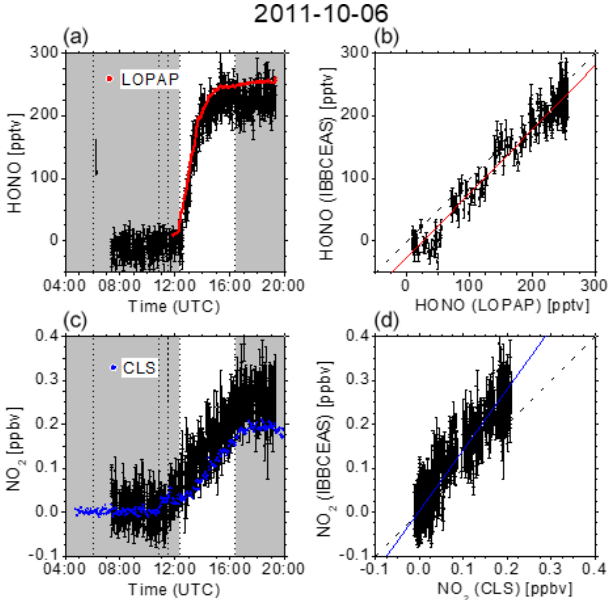
Figure 3. (a, c) Time-dependent HONO and NO 2 mixing ra- tios measured at SAPHIR on 5 October 2011. Dashed vertical lines indicate changes in the chamber conditions according to the experimental protocol: overnight flushing stopped (05:55UTC), 250pptv NO 2 (06:30 and 06:50UTC), 500pptv NO 2 (07:10 and 07:30UTC), 1ppbv NO 2 (07:50 and 08:10UTC), humidification started (08:41UTC), humidification stopped (09:25UTC), roof opened (09:27UTC), roof closed (14:23UTC), and flushing started (15:31UTC). IBBCEAS data taken in the near-UV region of the spectrum (352–386nm) are compared to LOPAP (red) and CLS (blue). The vertical black arrow indicates the time when I 0 was measured (generally for 10min). (b, d) Correlation plots of two in- struments being compared against IBBCEAS. The dashed line rep- resents the identity, and the coloured solid lines are linear regres- sions to the data. Results are listed in Table 1.